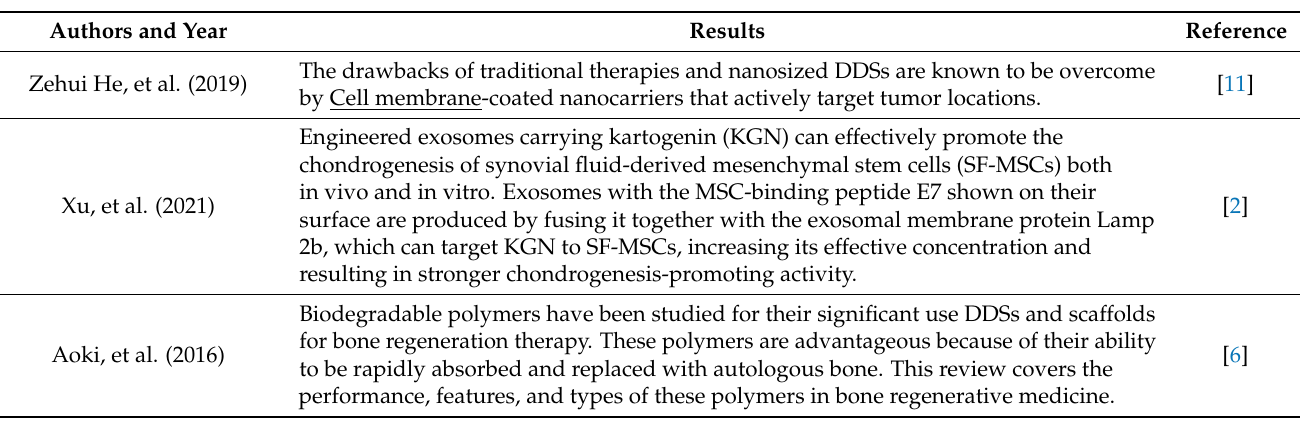
Table 2. The literature examining the enhanced drug delivery system using mesenchymal stem